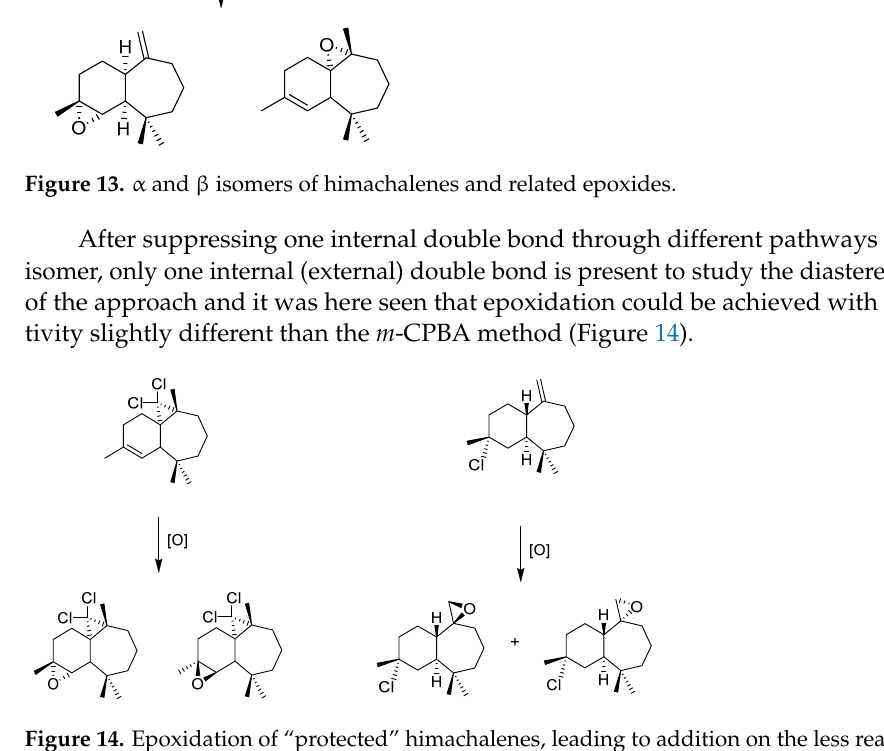
Figure 14. Epoxidation of “protected” himachalenes, leading to addition on the less reactive double bonds when himachalenes are unprotected.